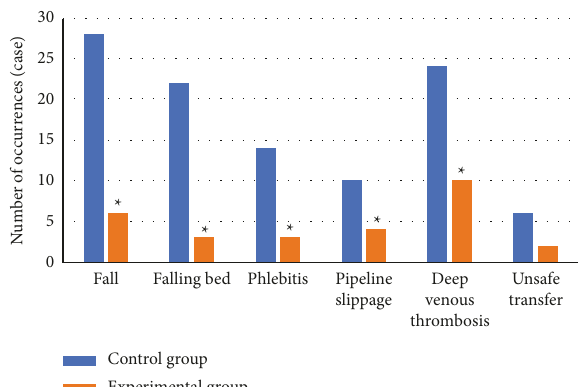
Figure 1: Comparison of occurrence of risk events. ( Note. ∗ represents a considerable difference vs. control group, P < 0 . 05).